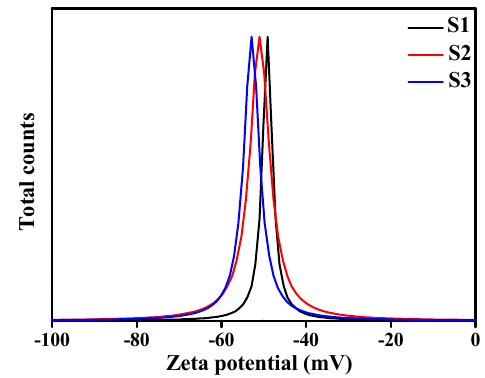
Figure 5. Zeta potential analysis.